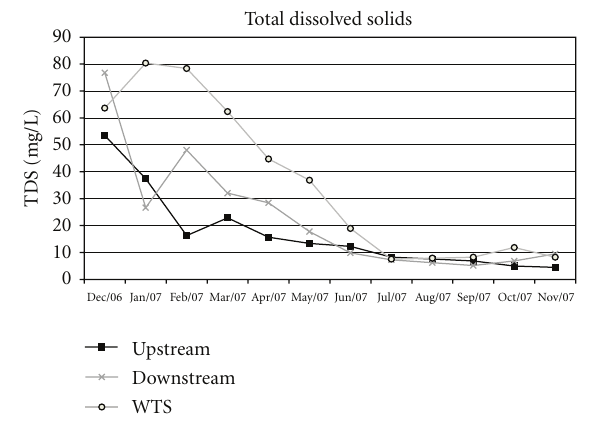
Figure 6: Monthly variation of TDS concentrations of the monitor- ing